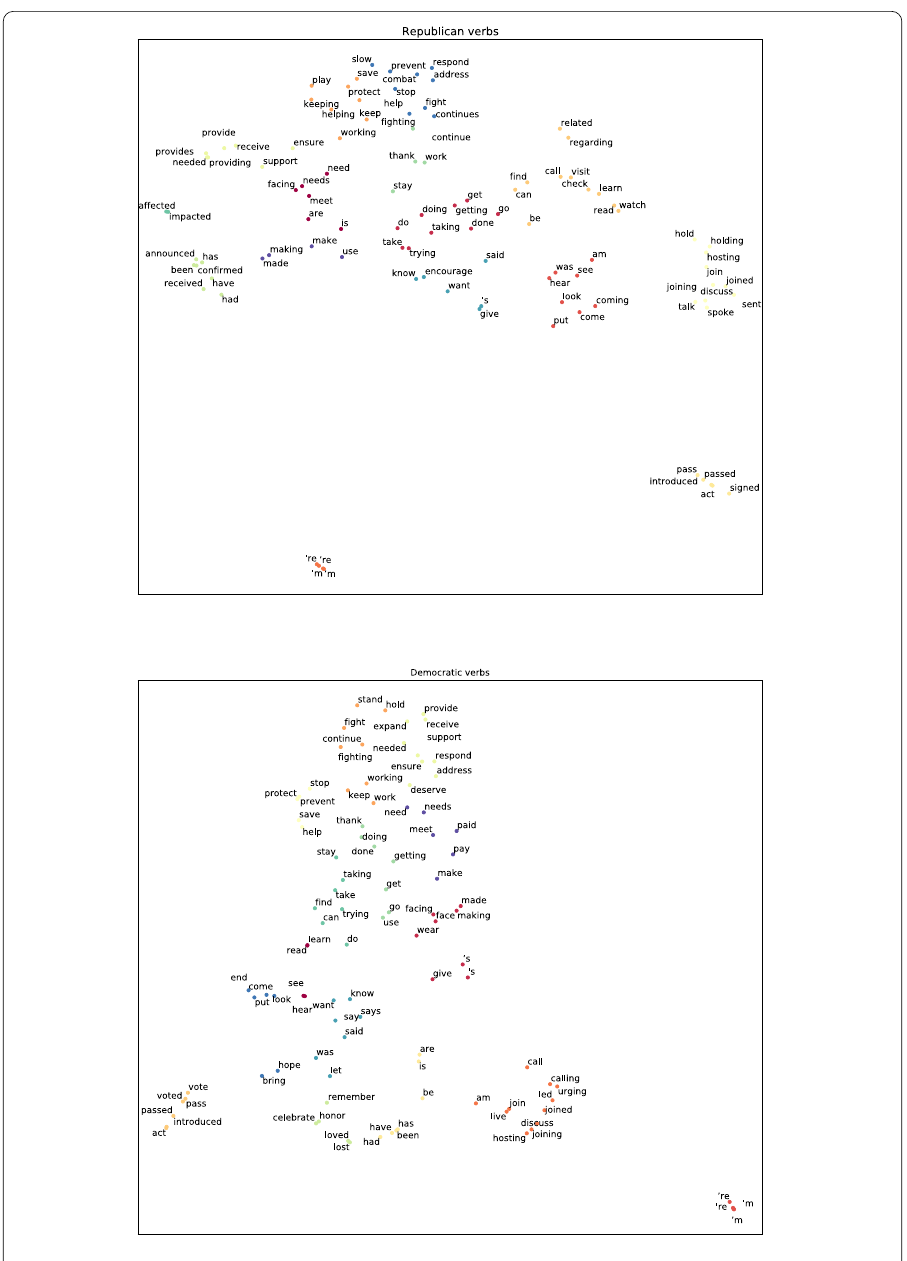
Figure 4 One-hundred most frequent verbs from Democratic and Republican tweets. Each verb is plotted using their GloVe embeddings with dimensionality reduced to 2 using UMAP. For each party, the verbs are grouped into 15 distinct clusters using the K-means algorithm. Colors of the points indicate cluster